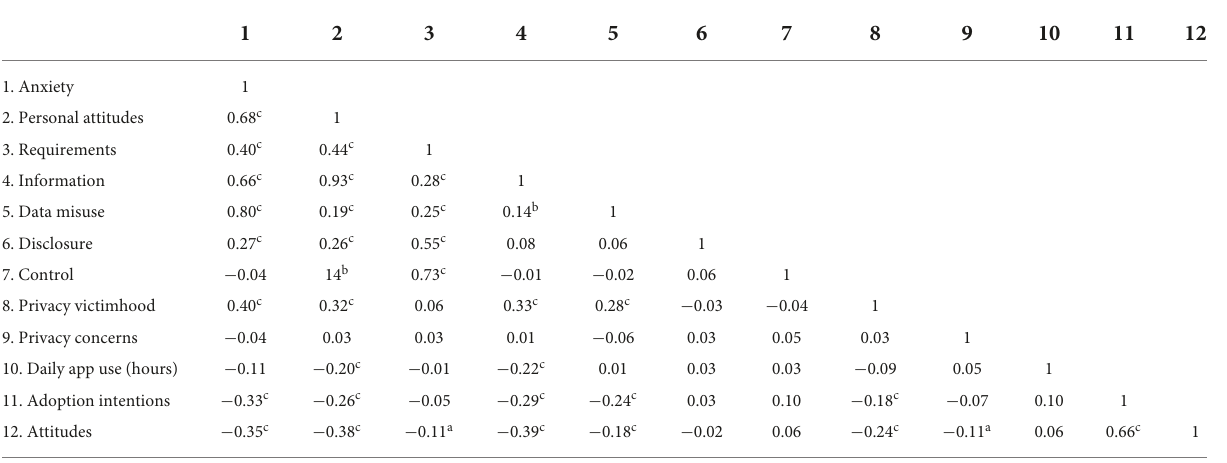
TABLE 4 Bivariate correlations between app information privacy concerns, daily app use, privacy concerns as a barrier to tracing app use, privacy victimhood, adoption intentions, and attitudes toward COVID-19 contact tracing apps ( N =